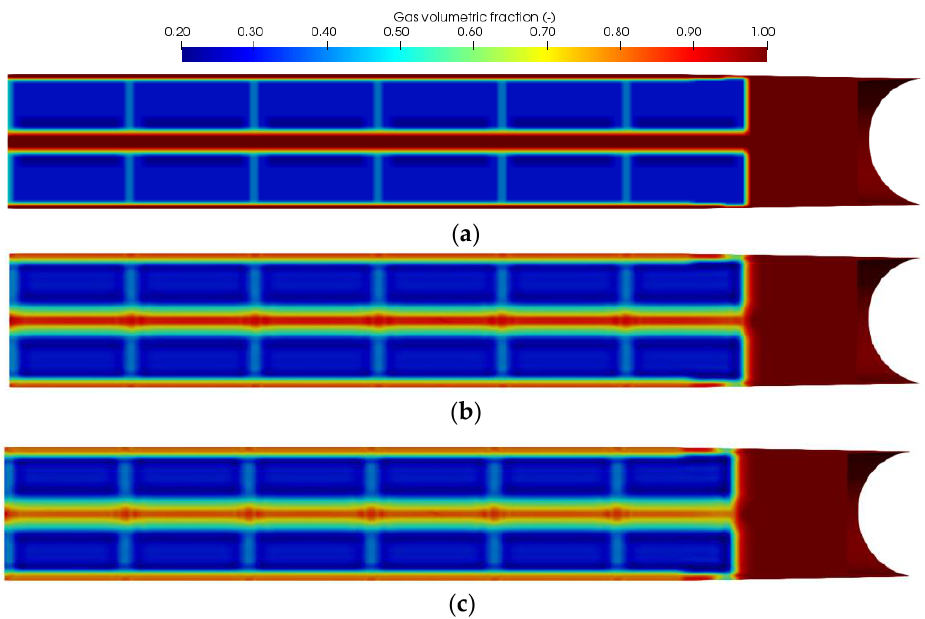
Figure 10. Three-dimensional numerical results for 155/52 six-module charge firing test. Gas volumetric fraction 𝛼 1 at different times: ( a ) 𝑡 = 0; ( b ) 𝑡 = 1.5 ms; ( c ) 𝑡 = 1.75 ms.